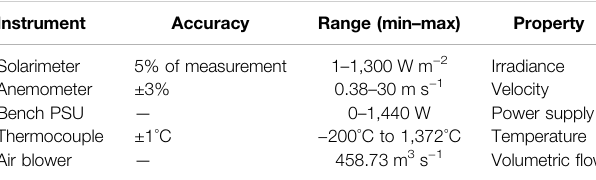
TABLE 2 | The speci fi cation of instruments used for experimental purposes. Instrument